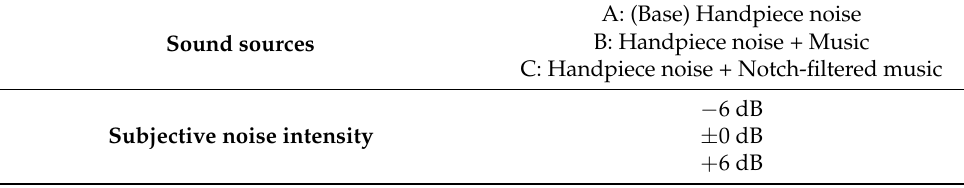
Table 2. The sound sources for clinical